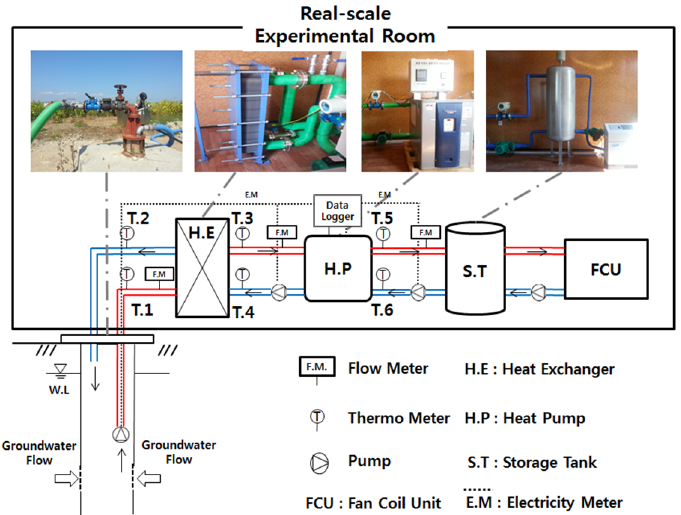
Figure 2. Schematic diagram of the Ground Source Heat Pump (GSHP) systems. Reproduced with permission from [14,18].